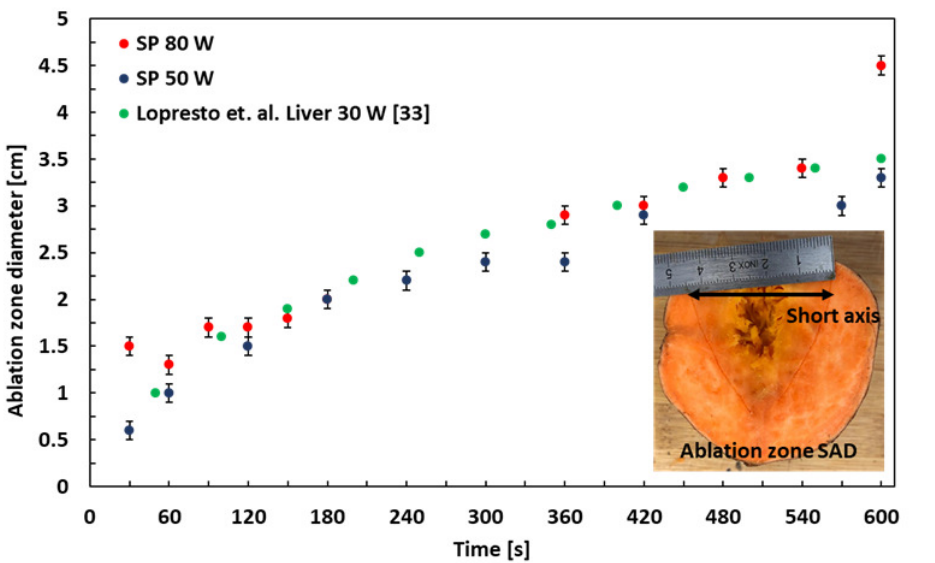
Figure 9. Ablation zone SAD as a function of time for 50 W and 80 W in SP and liver [33]. Figure 10 shows the SP MWA temperature as a function of time at 2.45 GHz for 50 and 80 W powers. The temperature measurements of SP are compared with those in MWA experiments in bovine liver at 60 W for 130 s, as reported in [14] and porcine liver at 75 W power for 300 s, as reported in [34]. The measurement values in the brown curve